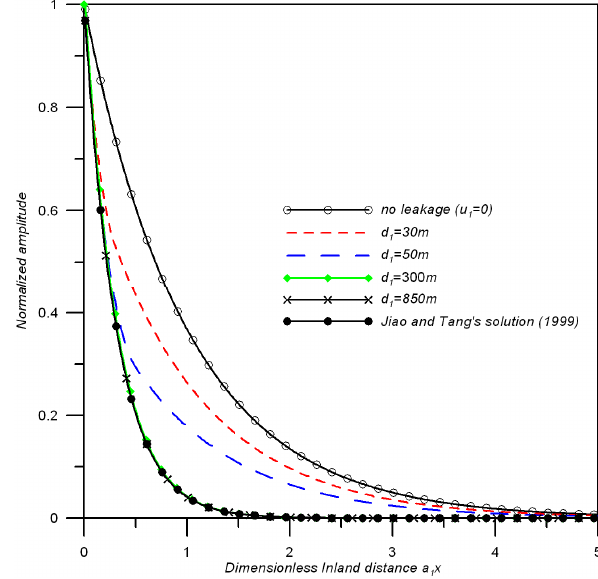
Figure 2. The curves of normalized amplitude of the head fluctuation versus dimensionless 3 Fig. 2. The curves of normalized amplitude of the head fluctuation inland distance for 5 1 = u , 0 2 = u , 2 21 101 − ×== aa m -1 , and various aquitard lengths 4 versus dimensionless inland distance for u 1 = 5, u 2 = 0, a 1 = a 2 = 1 × 10 − 2 m − 1 , and various aquitard